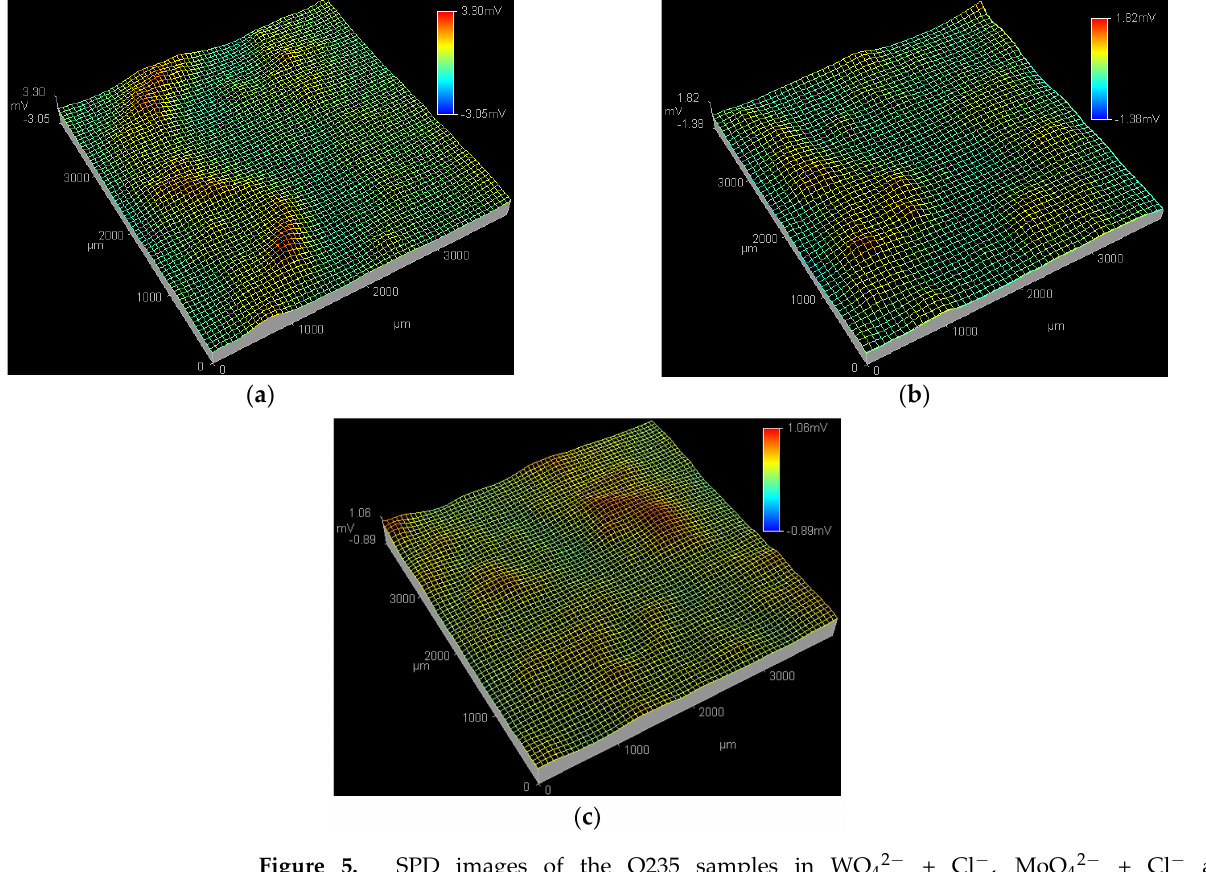
( b ) ( c ) Figure 4. SPD images of the Q235 samples in WO 4 2− + Cl − , MoO 4 2− + Cl − and WO 4 2− + MoO 4 2− + Cl − solutions at applied potential of 0.09 V SCE : ( a ) WO 4 2− + Cl − solution, ( b ) MoO 4 2− + Cl − solution and ( c ) WO 4 2− + MoO 4 2− + Cl − solution. Figure 5 shows the SPD images of the Q235 samples in WO 4 2− + Cl − , MoO 4 2− + Cl − and WO 4 2− + MoO 4 2− + Cl − solutions at the applied potential of 0.17 V SCE . In WO 4 2− + Cl − solution, both the peak potential and affected region of the active pitting sites at 0.17 V SCE further